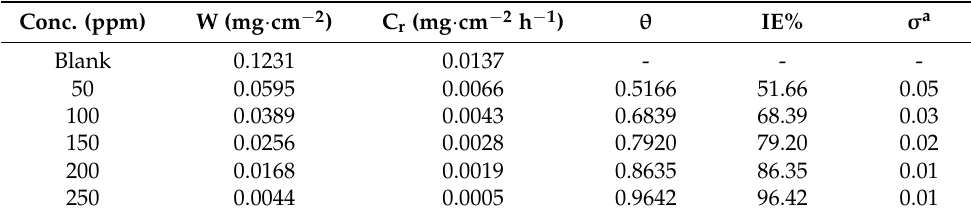
Table 1. IE of T. aralioides for various concentrations against MS in 1M HCl at 303 ± 1 K by weight loss measurements.